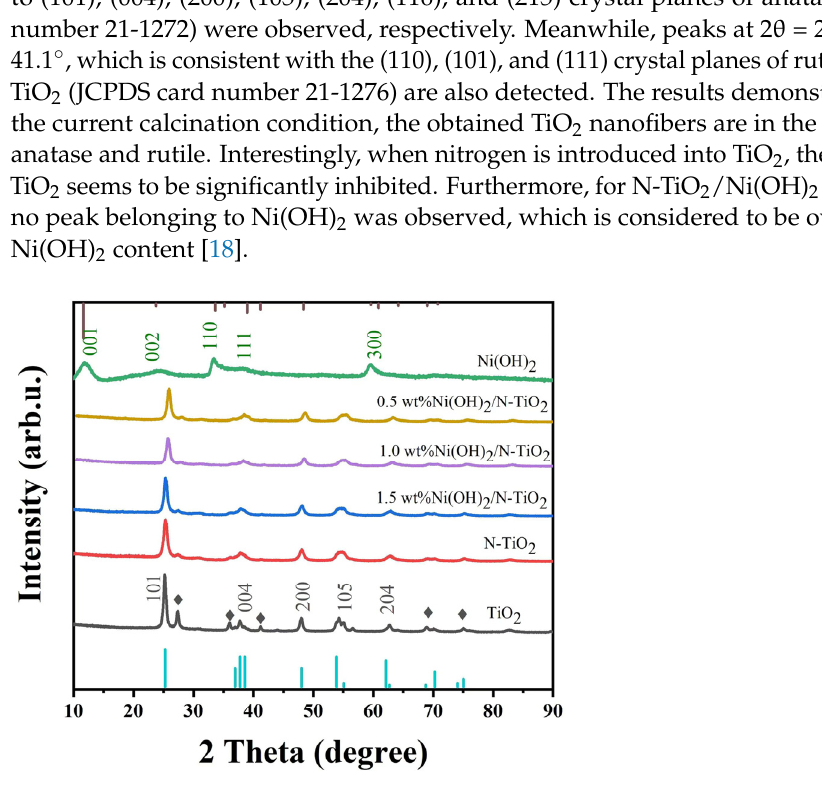
Figure 1. X-ray di ff raction (XRD) pa tt erns of TiO 2 , N-TiO 2 , Ni(OH) 2 , and N-TiO 2 /Ni(OH) 2 with dif- Figure 1. X-ray diffraction (XRD) patterns of TiO 2 , N-TiO 2 , Ni(OH) 2 , and N-TiO 2 /Ni(OH) 2 with ferent amount of Ni(OH) 2 . The rectangle indicates the rutile phase of TiO 2 . different amount of Ni(OH) 2 . The rectangle indicates the rutile phase of TiO 2